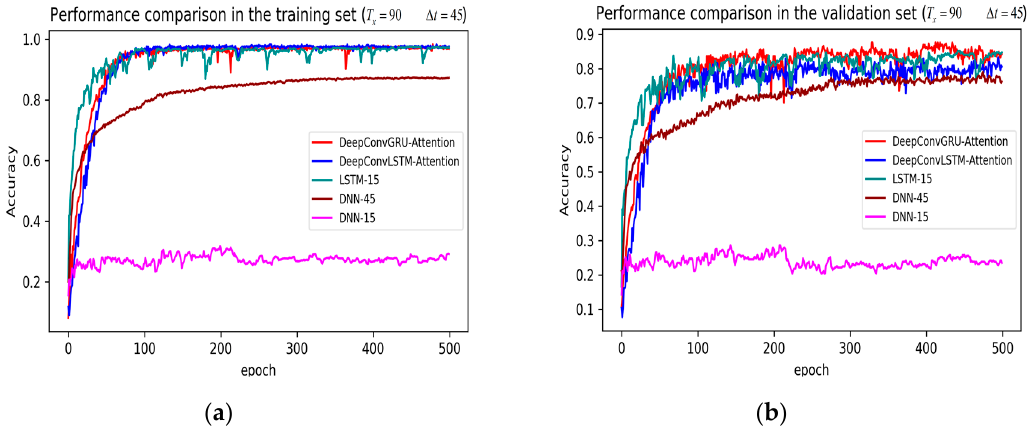
Figure 10. Performance comparison of different models in accuracy using 51 original features when setting T x to 90 samples and ∆ t to 45 samples. ( a ) Performance comparison in the training stage. ( b ) Performance comparison in the validation stage. Here, DeepConvGRU and DeepConvLSTM using the original 51D features performed similar to LSTM and DNN using the selected 15D features and statistical 45D features. In addition, DNN using selected 15D features also could not be converged.